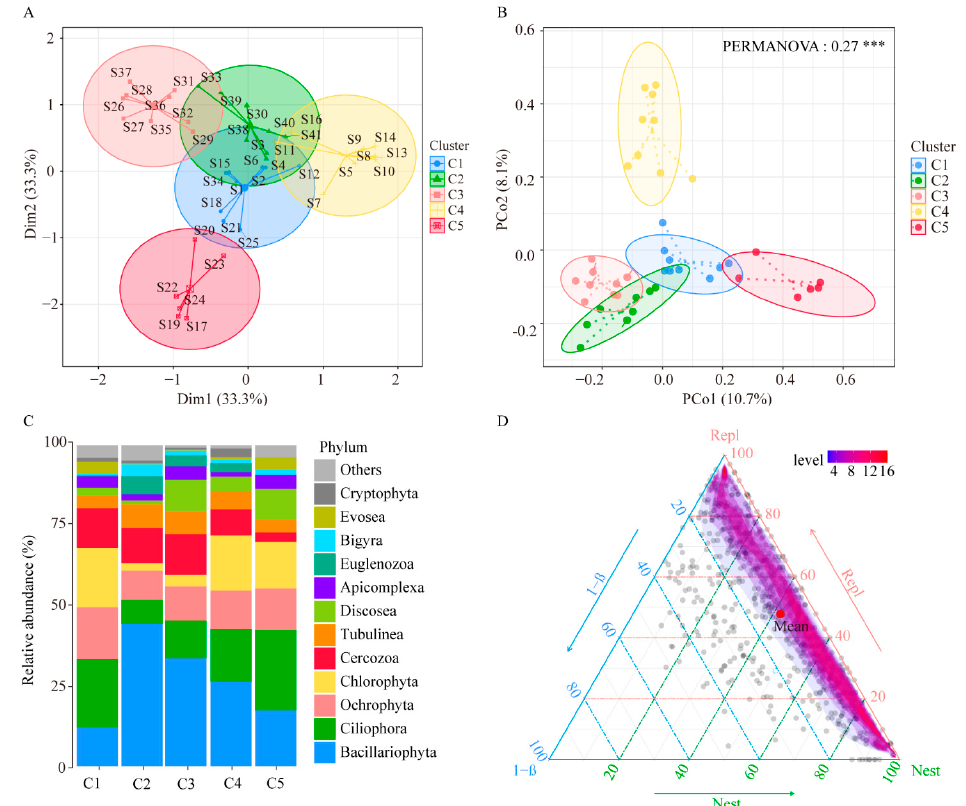
Figure 4. Beta diversity of protists. ( A ) Cluster analysis of protist communities in all sample sites. ( B ) Principal coordinate analysis (PCoA) and analysis of PERMANOVA of protist communities in the five clusters. ( C ) Relative abundance of the main phyla of protists in the five clusters. ( D ) The triangular plot of protist communities made by using the Sørensen index. Notes: *** p ≤ 0.001. Beta diversity can reflect two different phenomena, the spatial turnover or replace- ment (Repl), and the species loss or nestedness (Nest) of assemblages, which result from two antithetic processes. The Repl is caused by changes in species abundance, and the Nest is caused by the loss of species. Both Repl and Nest are important concepts for un- derstanding the spatial distribution and variation of beta diversity. We used the Jaccard method to calculate and partition total beta diversity to understand the relative contribu- tion of Repl and Nest to overall beta diversity. The results of the relative contribution for Repl and Nest show that in protist communities, the mean contributions of the turnover pattern results from the Repl and Nest components to the beta diversity were 47.80% and 42.04%, respectively (Figure 4D). The results show that the turnover and nestedness com- ponent jointly affected the species composition difference (beta diversity) among commu- nities.